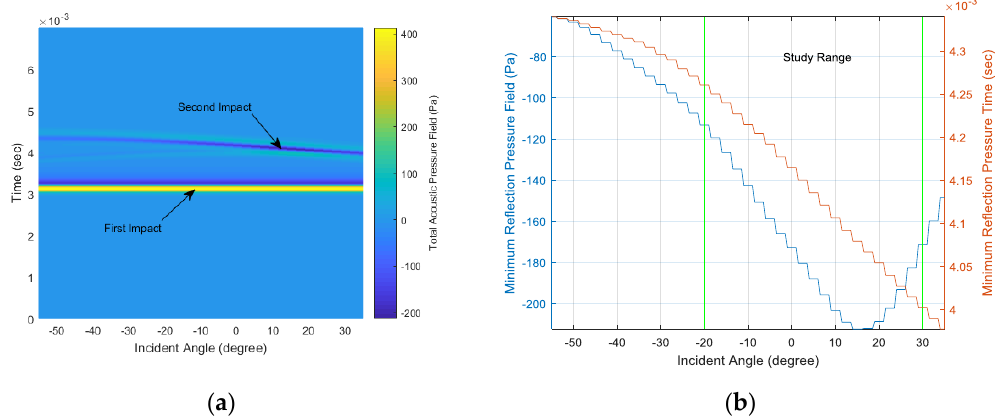
Figure 9. ( a ) Simulated received signals with various angles at a 2.5° step and ( b ) the second arrival magnitude (left y-axis) and time (right y-axis).